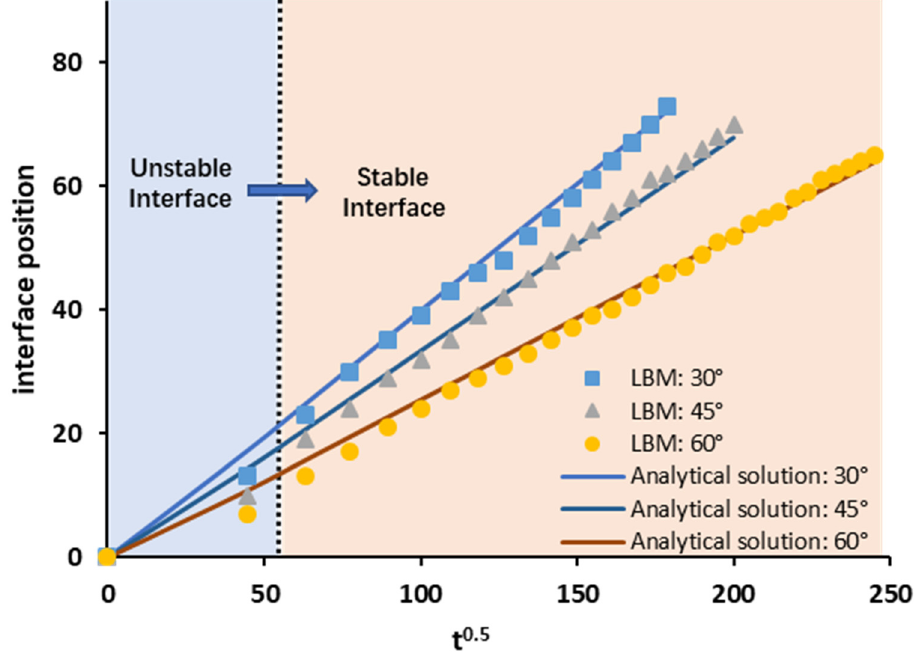
Figure 7. Simulation of spontaneous imbibition in a simple capillary for different wetting angles.